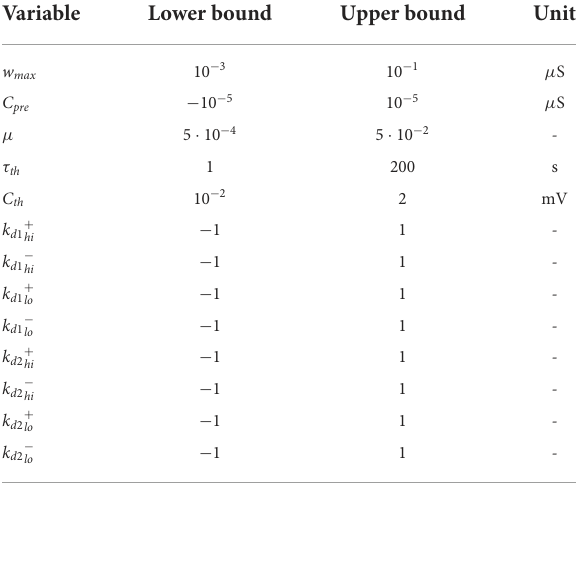
TABLE 1 Parameters to tune for the neural model and their allowed ranges. Variable Lower bound Upper